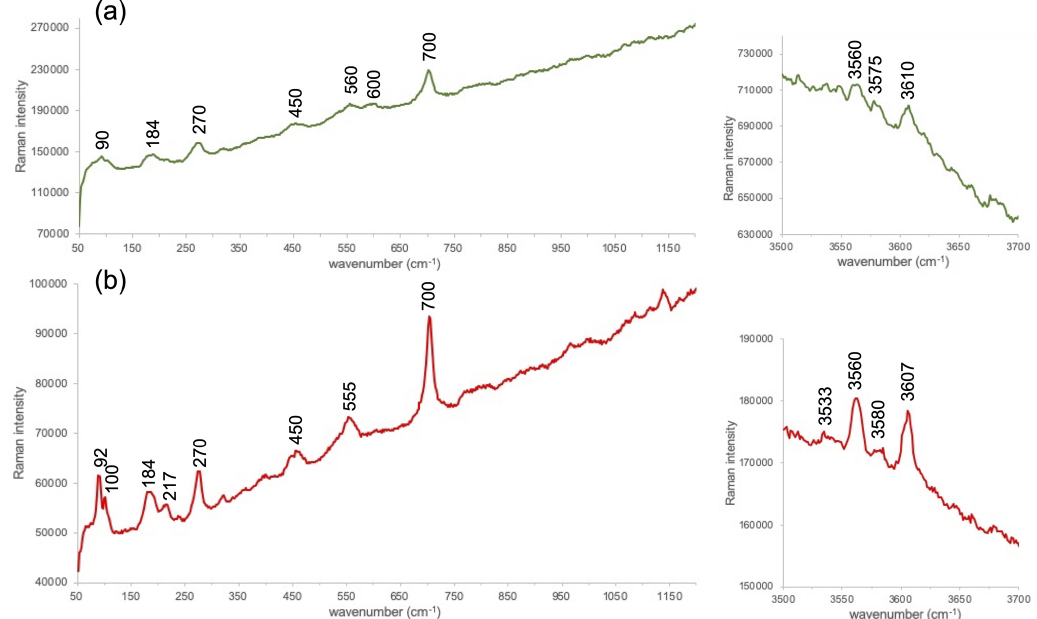
Figure 9. Representative Raman spectra of the two types of green micas: glauconite (a) and celadonite (b) obtained at the 532nm excitation wavelength and corresponding to two regions (see “Methods” for explanation). The intensity scale is in total